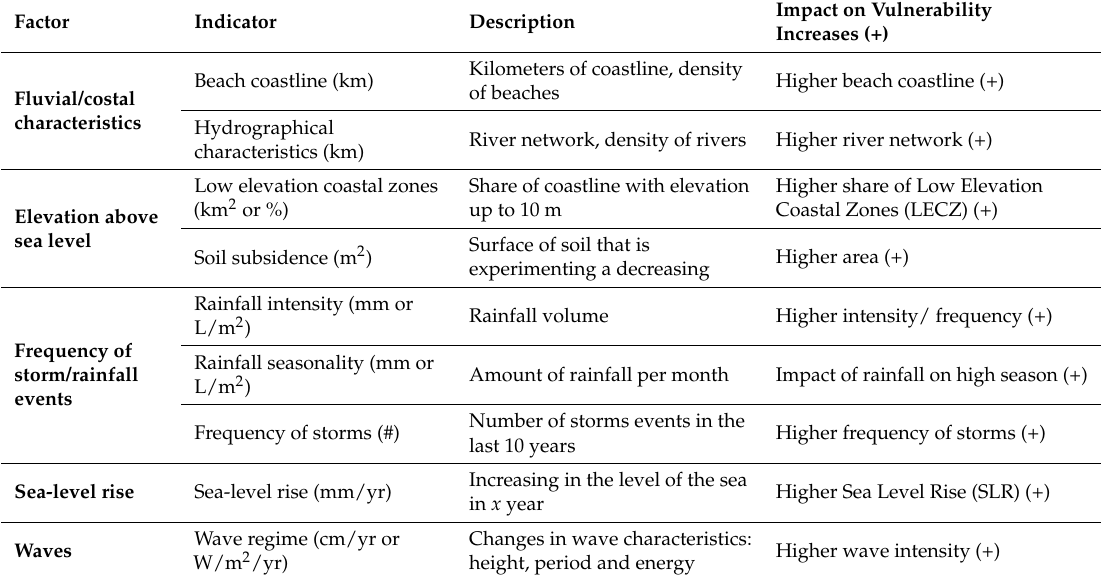
Table 1. Exposure indicators of the hydro-geomorphological subsystem.